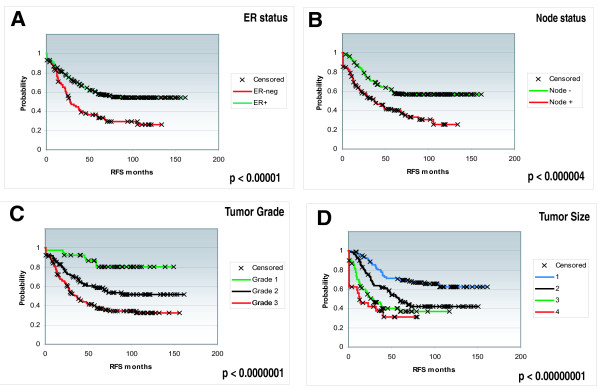
Kaplan-Meier survival curves using RFS as the endpoint, for the common clinical parameters present within the 315-sample combined test set. Survival curves are shown for (A) ER status, (B) node status, (C) histologic grade (1 = well-differentiated, 2 = intermediate, 3 = poor), and (D) tumor size (1 = diameter of 2 cm or less; 2 = diameter greater than 2 cm and less than or equal to 5 cm; 3 = diameter greater than 5 cm; 4 = any size with direct extension to chest wall or skin).